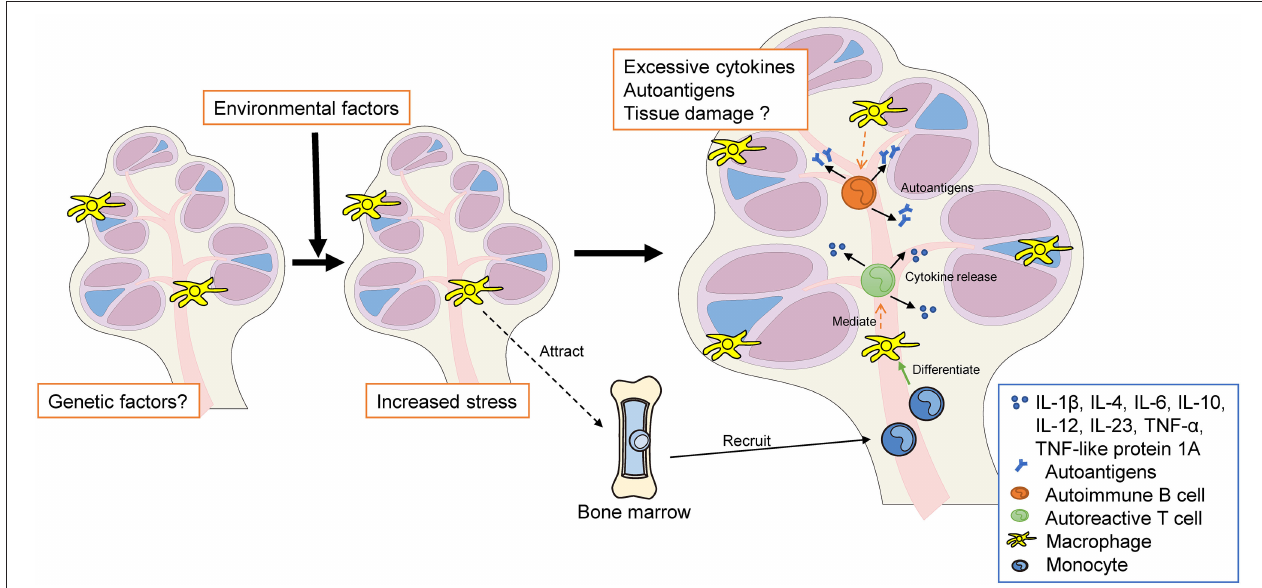
FIGURE 4 | The hypothesis of autoimmune and autoinflammatory diseases in the inner ear. Genetic and/or environmental factors increase both systemic stress and local stress in the inner ear (e.g., MS, SLE, autoimmune uveitis, MWS, and IBD). Resident cochlear M ϕ s may be activated to a pro-inflammatory state. Pro-inflammatory macrophages release cytokines that recruit monocytes into the cochlea. These infiltrating monocytes differentiate into macrophages within the cochlea, following which they participate in phagocytosis, inflammatory mediator production, and antigen presentation. Excessive autoantigen and cytokine release may cause cochlear autoinflammation and sensorineural hearing loss. MS, multiple sclerosis; SLE, systemic lupus erythematosus; MWS, Muckle–Wells syndrome; IBD, inflammatory bowel disease; M ϕ , macrophage, BM, bone marrow; TNF, tumor necrosis factor; IL,